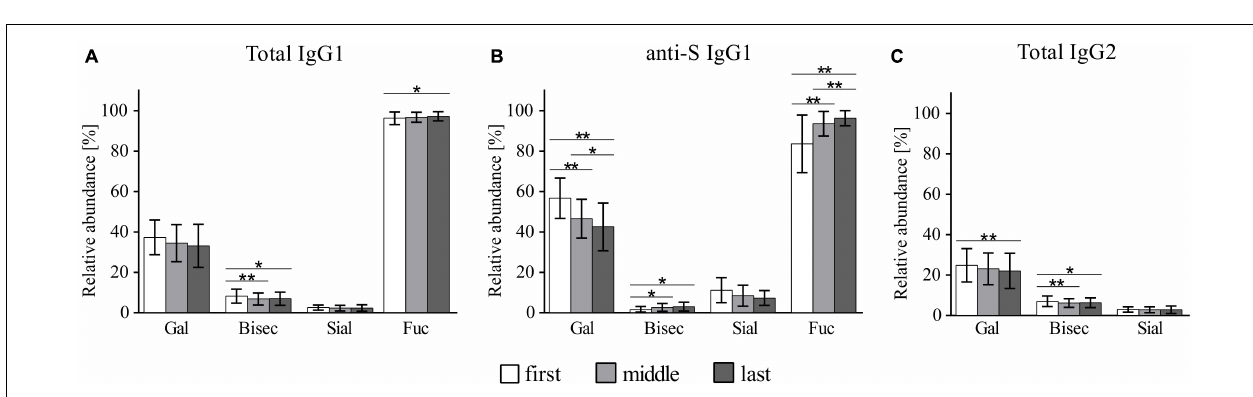
FIGURE 3 | Profiles of COVID-19-related glycosylation alterations in (A) total IgG 1 , (B) anti-S IgG 1 , and (C) total IgG 2 . * p < 0.05, ** p < 0.01. The calculation of the glycosylation traits Gal, Bisec, Sial, and Fuc is given in section “MALDI-TOF Measurements and Data Analysis.”